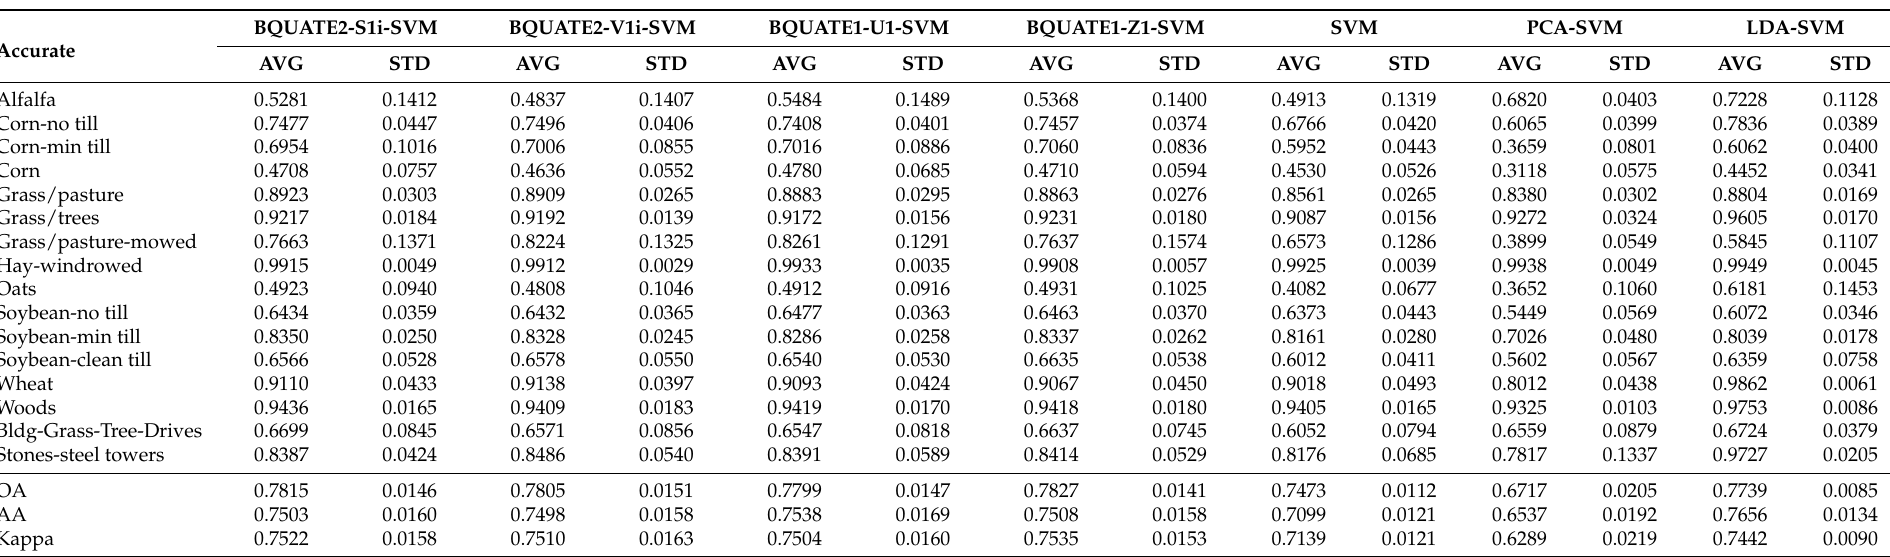
Table 18. The classification performance of BQUATE2-S1i-SVM, BQUATE2-V1i-SVM, BQUATE1-U1-SVM, BQUATE1-Z1-SVM, SVM, PCA-SVM, and LDA-SVM on Indian